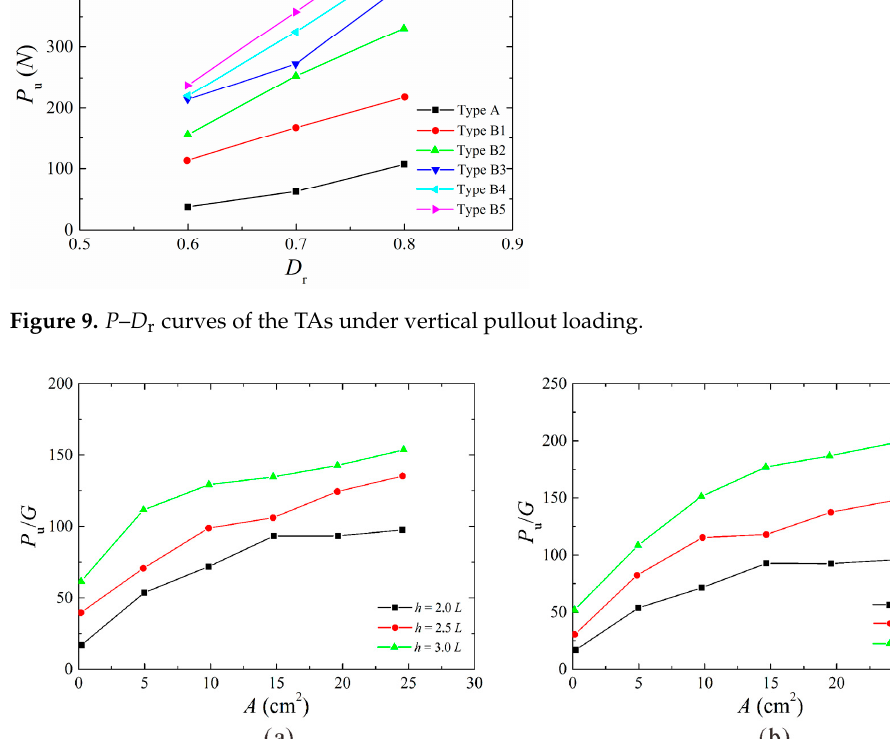
r = 0.6; ( b ) h = 2.0 L